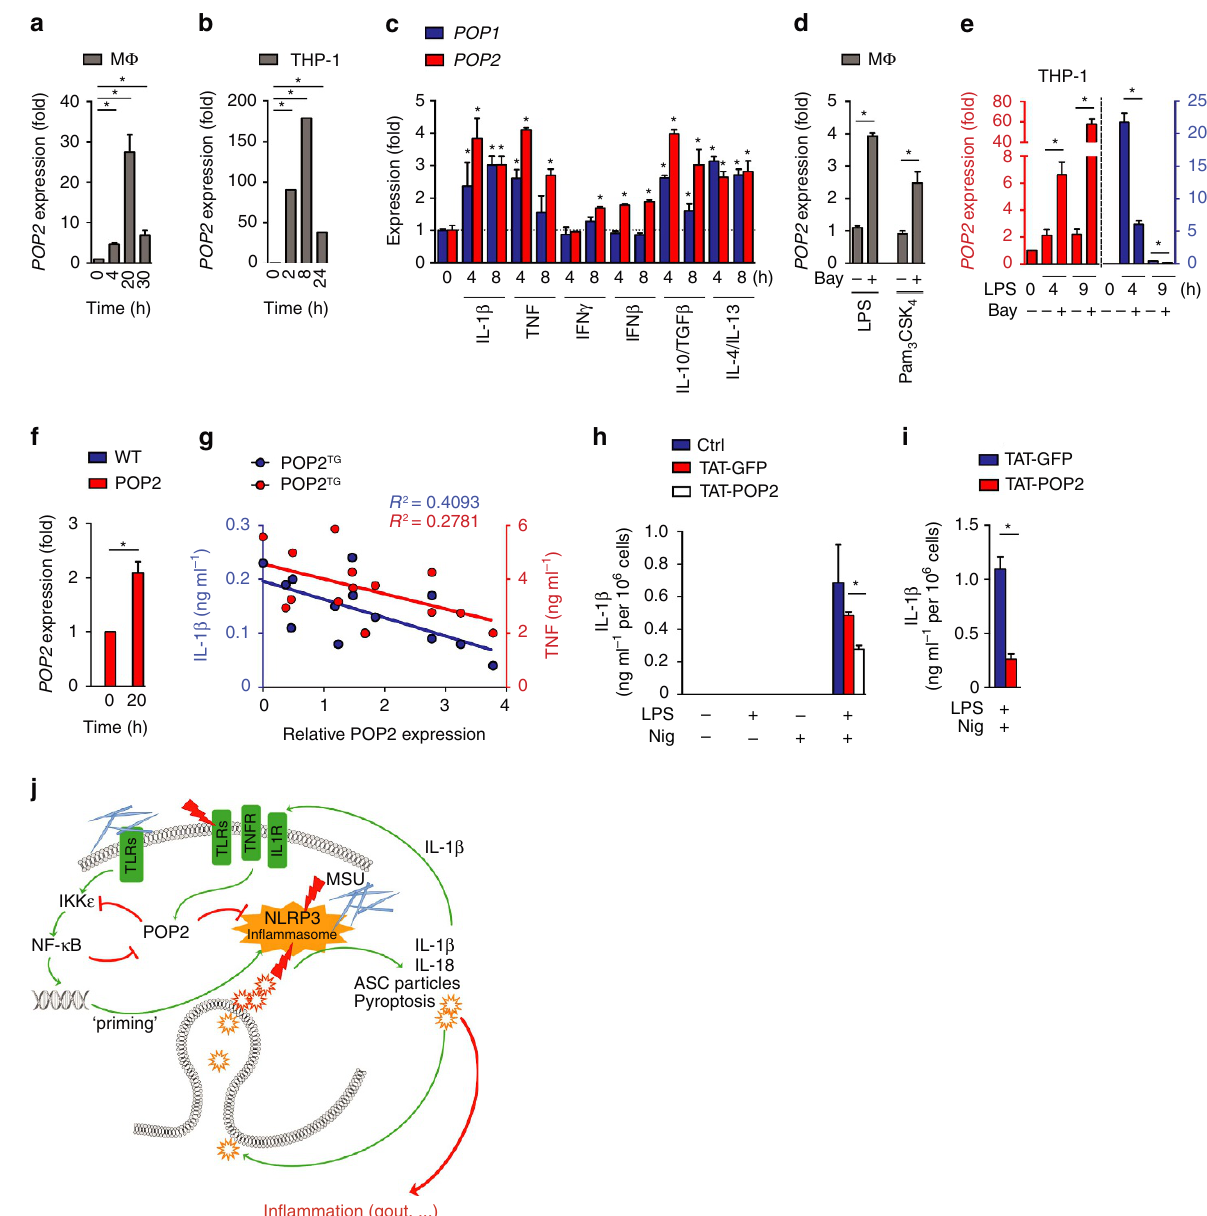
Figure 6 | POP2 expression is induced in response to pro- and anti-inflammatory cytokines. ( a – f ) POP2 , POP1 and TNF transcripts as indicated were measured by real-time PCR in ( a , c , d ) primary human macrophages (M F ). ( b , e ) THP-1 cells and ( f ) WTand POP2 BMDM treated with various pro- and anti-inflammatory PAMPs and cytokines for the indicated times. ( d , e ) Cells were pretreated with LPS or Pam 3 CSK 4 for 1h and then further incubated in d for a total of 4h and ( e ) 4 and 9h in the presence of the NF- k B inhibitor Bay11-7082. ( g ) POP2 expression in BMDM isolated from individual POP2 TG mice was determined by immunoblot and densitometric quantification and correlated to the release of IL-1 b in response to nigericin or the release of TNF in LPS-primed cells and was analysed by linear regression. ( h , i ) TAT-GFP or TAT-POP2 (0.28 m M) was added to the culture medium of unprimed or LPS-primed ( h ) BMDM and ( i ) iBMDM for 30min followed by 45min treatment with nigericin. IL-1 b release was quantified by ELISA. ( j ) Proposed function of POP2 as a dual regulator that simultaneously inhibits NF- k B-mediated inflammasome priming and nucleation in macrophages in response to MSU crystals and other activators. POP2 is positioned in a negative feedback loop for inflammasome regulation since it is upregulated by IL-1 b , which is blocked upon POP2 expression. For NF- k B signalling POP2 is positioned in a feed-forward regulatory loop since its inhibition of NF- k B leads to POP2 upregulation. Together, POP2 efficiently prevents cytokine release and pyroptosis. Three independent repeats were performed for each experiment in a – i . Significance was calculated by a standard two-tailed unpaired t -test, and error bars represent s.e.m., * P o